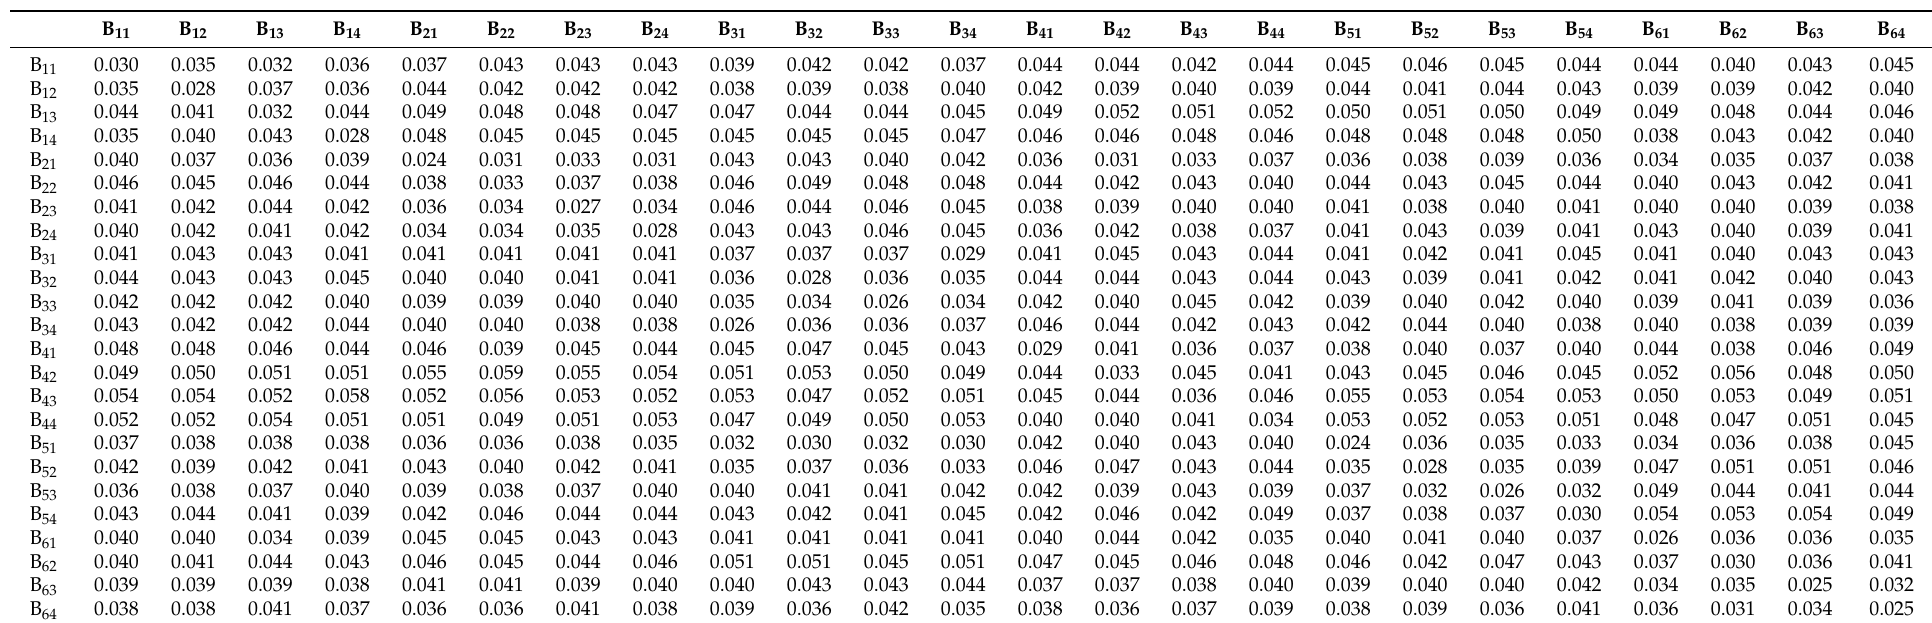
Table 5. Weighted hypermatrix of secondary